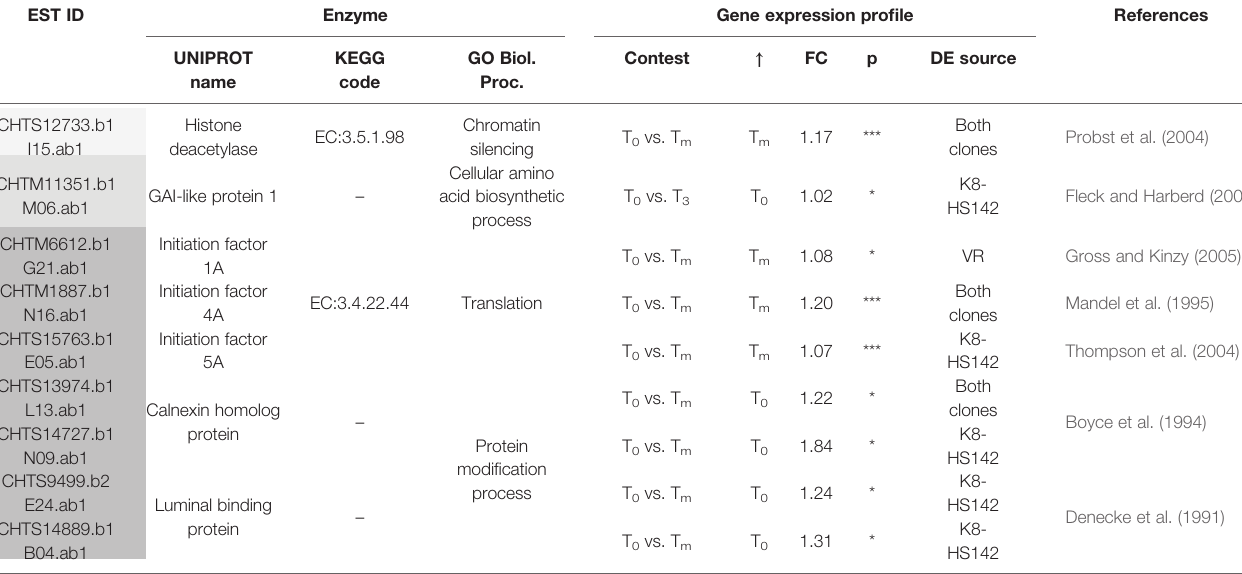
TABLE 8 | Differentially expressed (DE)/expressed sequence tags (ESTs) between tuber stages taking a role the metabolism of nucleic acids and proteins. EST ID Enzyme Gene expression pro fi